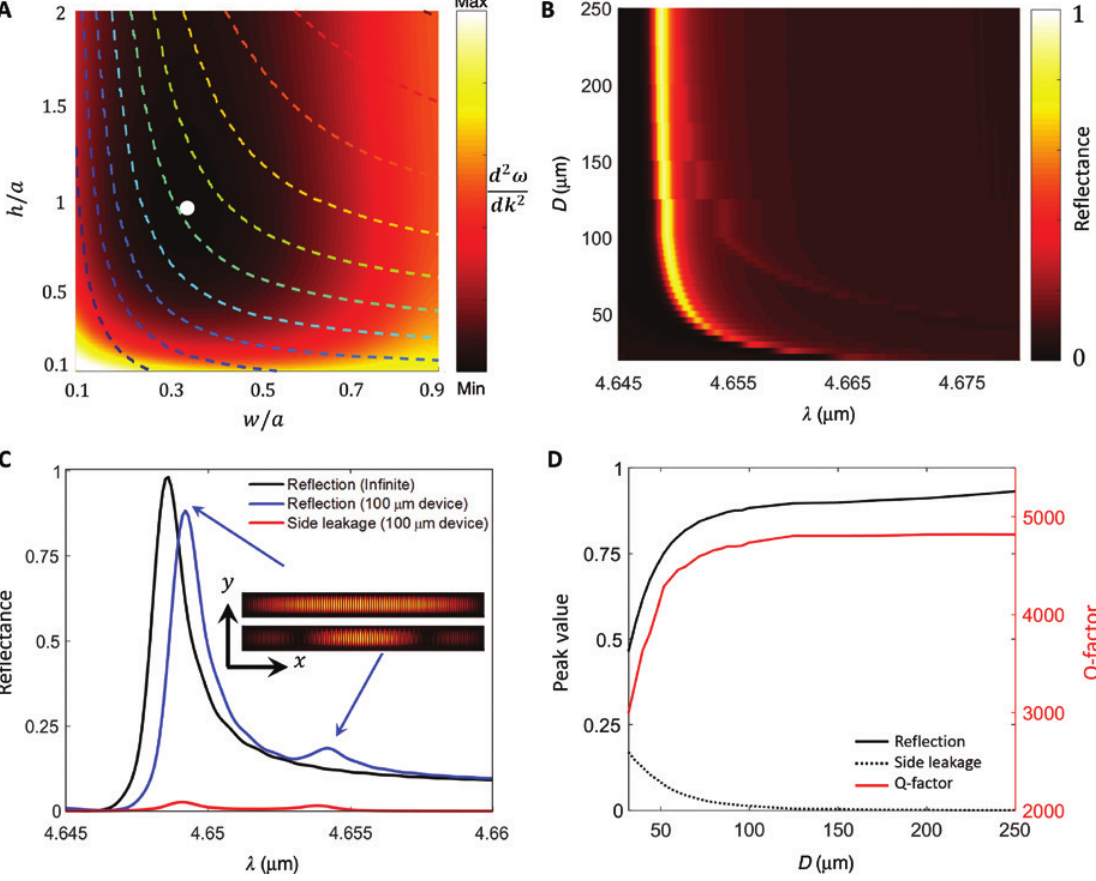
Figure 4: Finite-size effects in